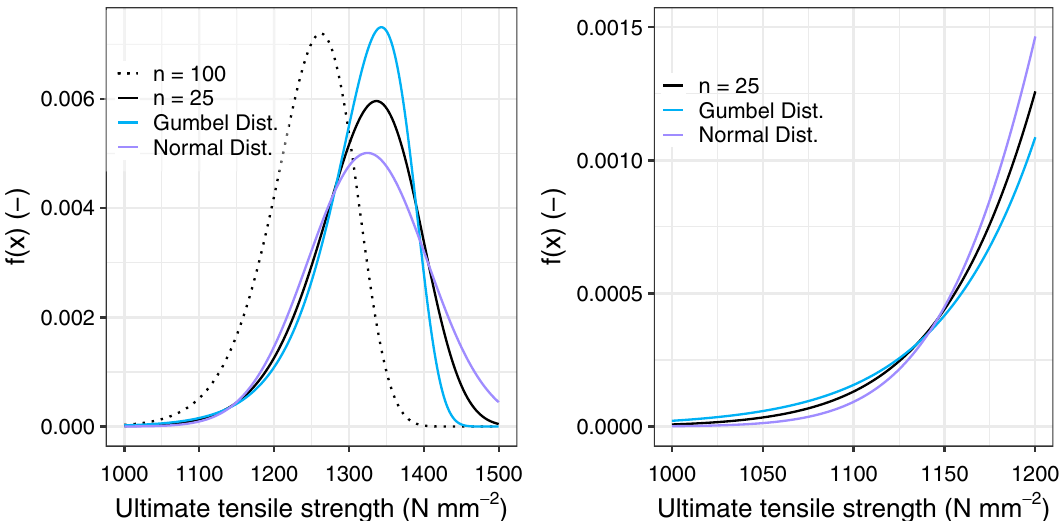
Figure 8. Probability-Density-Function of the extreme-value function and the approximation through a Normal and a Gumbel distribution functions ( a ) entire distribution and ( b ) selected area of the distribution at the tails.